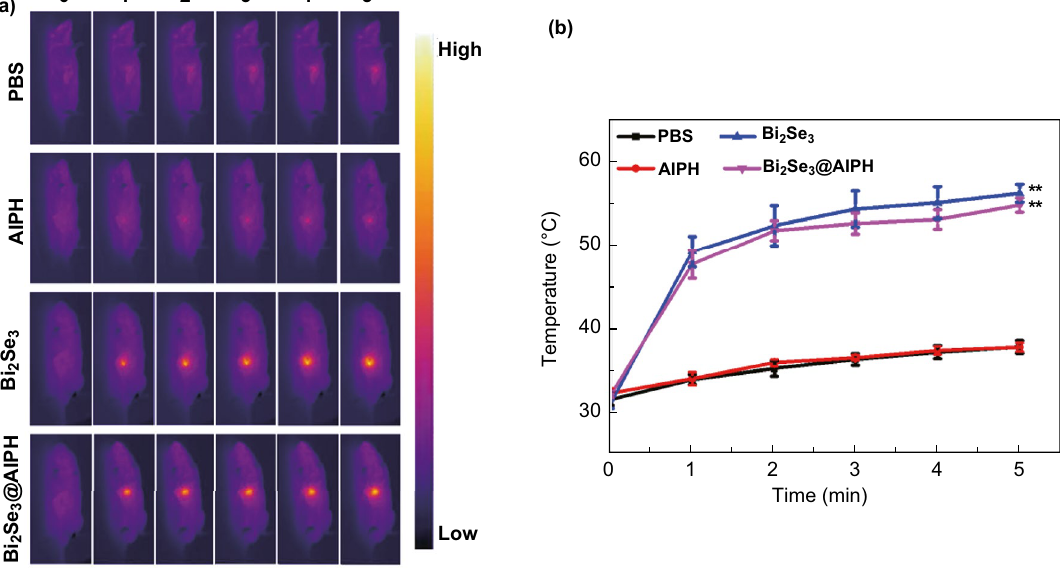
Fig. 5 a In vivo photothermal images and b the corresponding temperature change in mice after the injection of PBS, AIPH, Bi 2 Se 3 , and